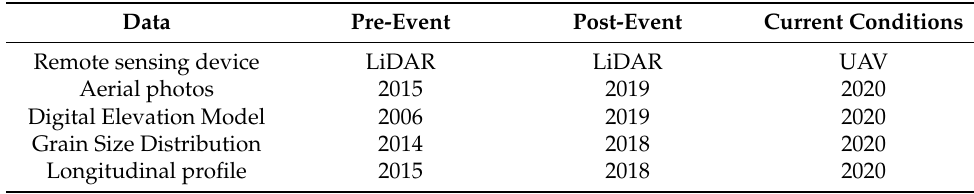
Table 1. Date and typologies of data used for the